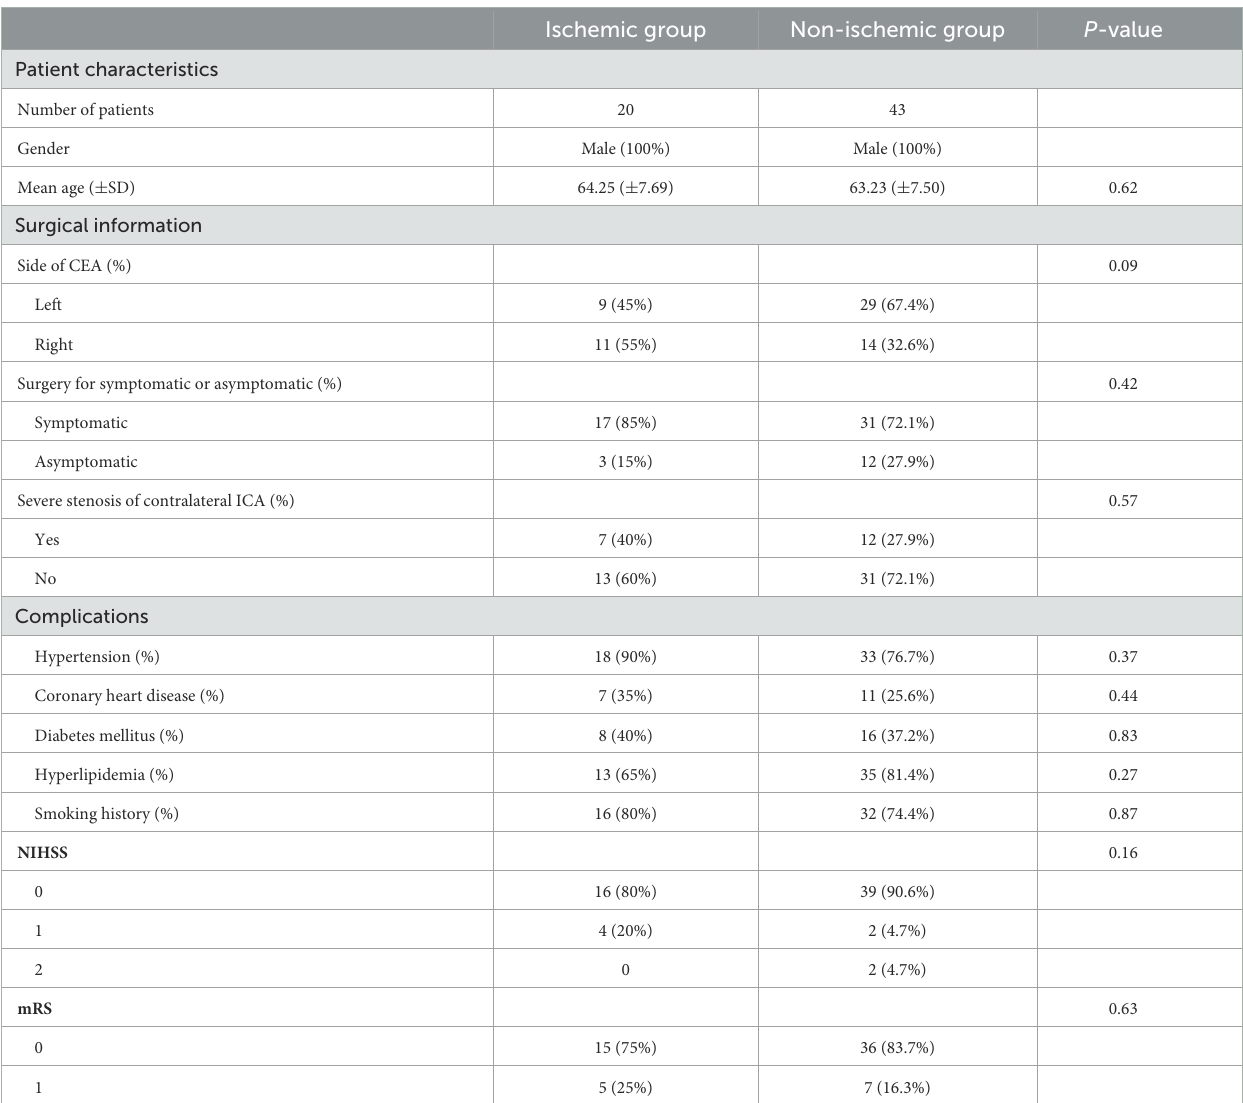
TABLE 1 Patients demographics and characteristics.